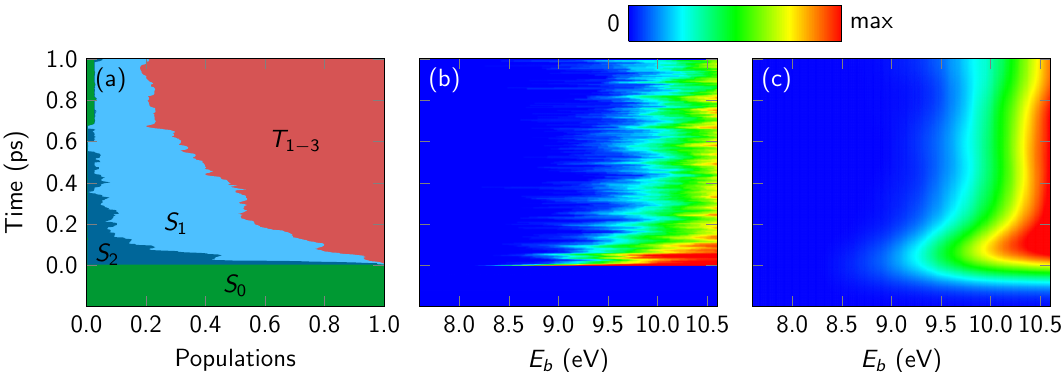
Figure 3. Electronic populations from the S HARC simulations ( a ) and simulated TRPE spectra without ( b ) and with ( c ) temporal broadening (full width at half maximum of 190 fs) added. E b is the binding energy, whose upper limit (10.6 eV) is equal to the sum of pump and probe energies (4.2 eV and 6.4 eV). The rectangular line shape function and intensities proportional to Dyson norms were